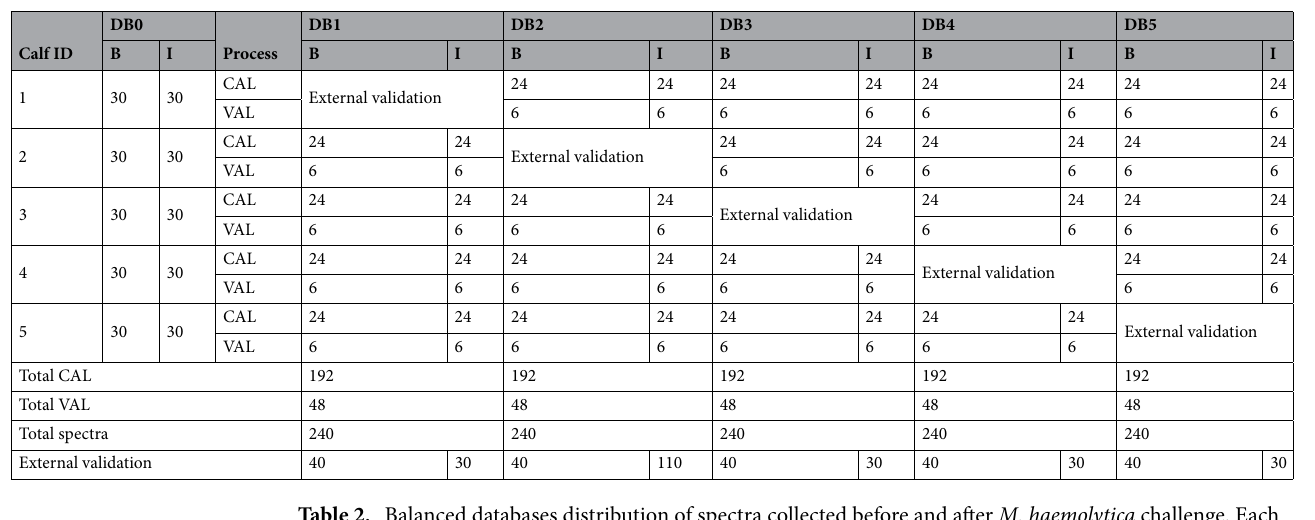
Table 2. Balanced databases distribution of spectra collected before and after M. haemolytica challenge. Each database has spectra from one animal removed for external validation. DB, Database; B, Baseline; I, Infected; CAL, Calibration; VAL, Internal